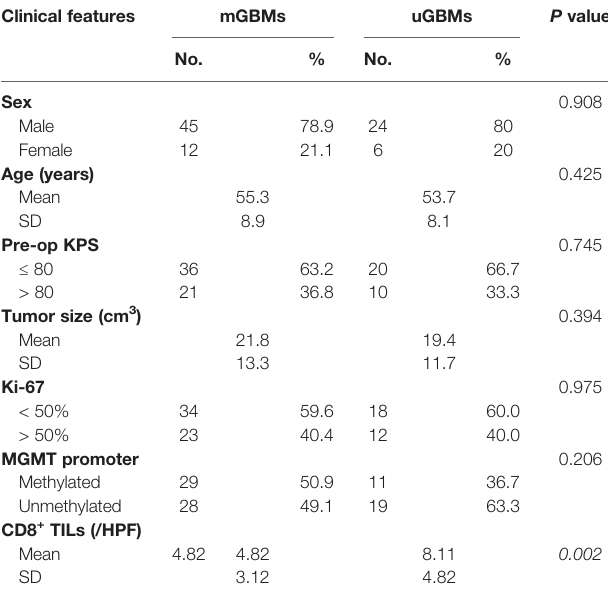
TABLE 2 | Comparison of mGBMs and uGBMs. Clinical features